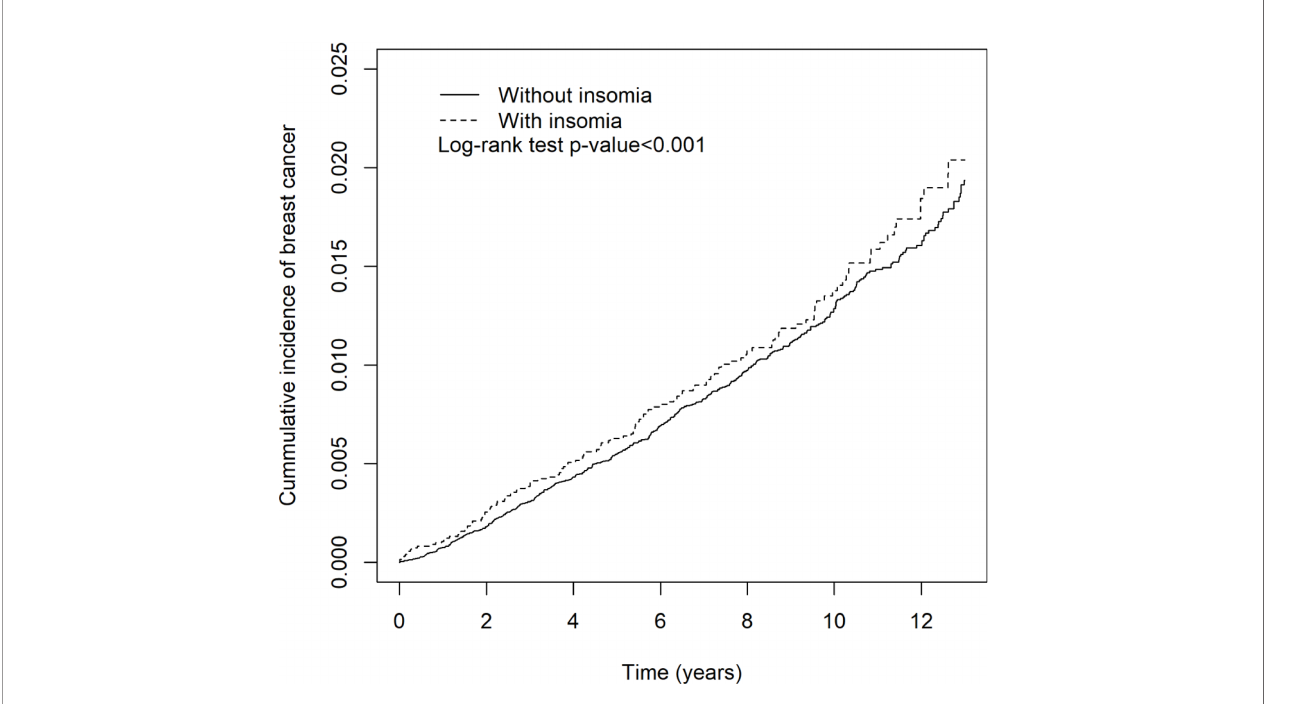
FIGURE 2 | The cumulative incidence of breast cancer in patients with and without